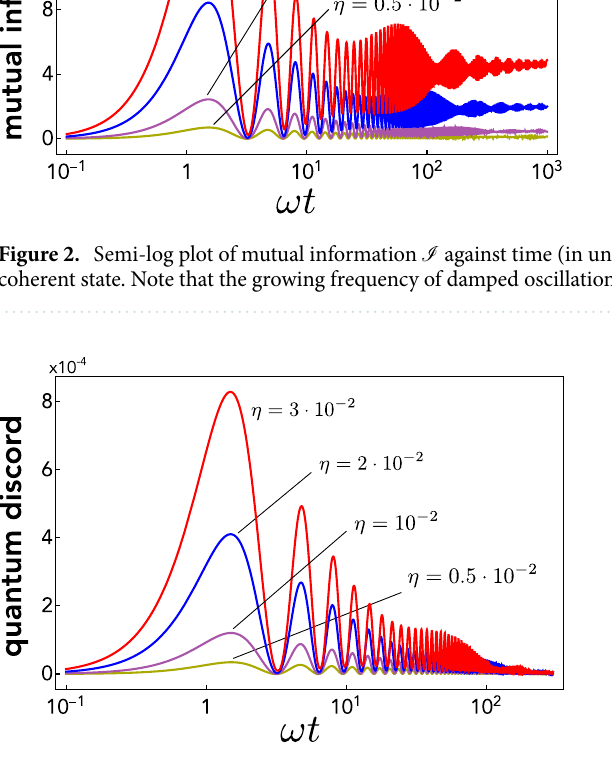
Figure 3. Semi-log plot of quantum discord D against time (in units of ω − coherent state. Discord D was calculated using Eq.